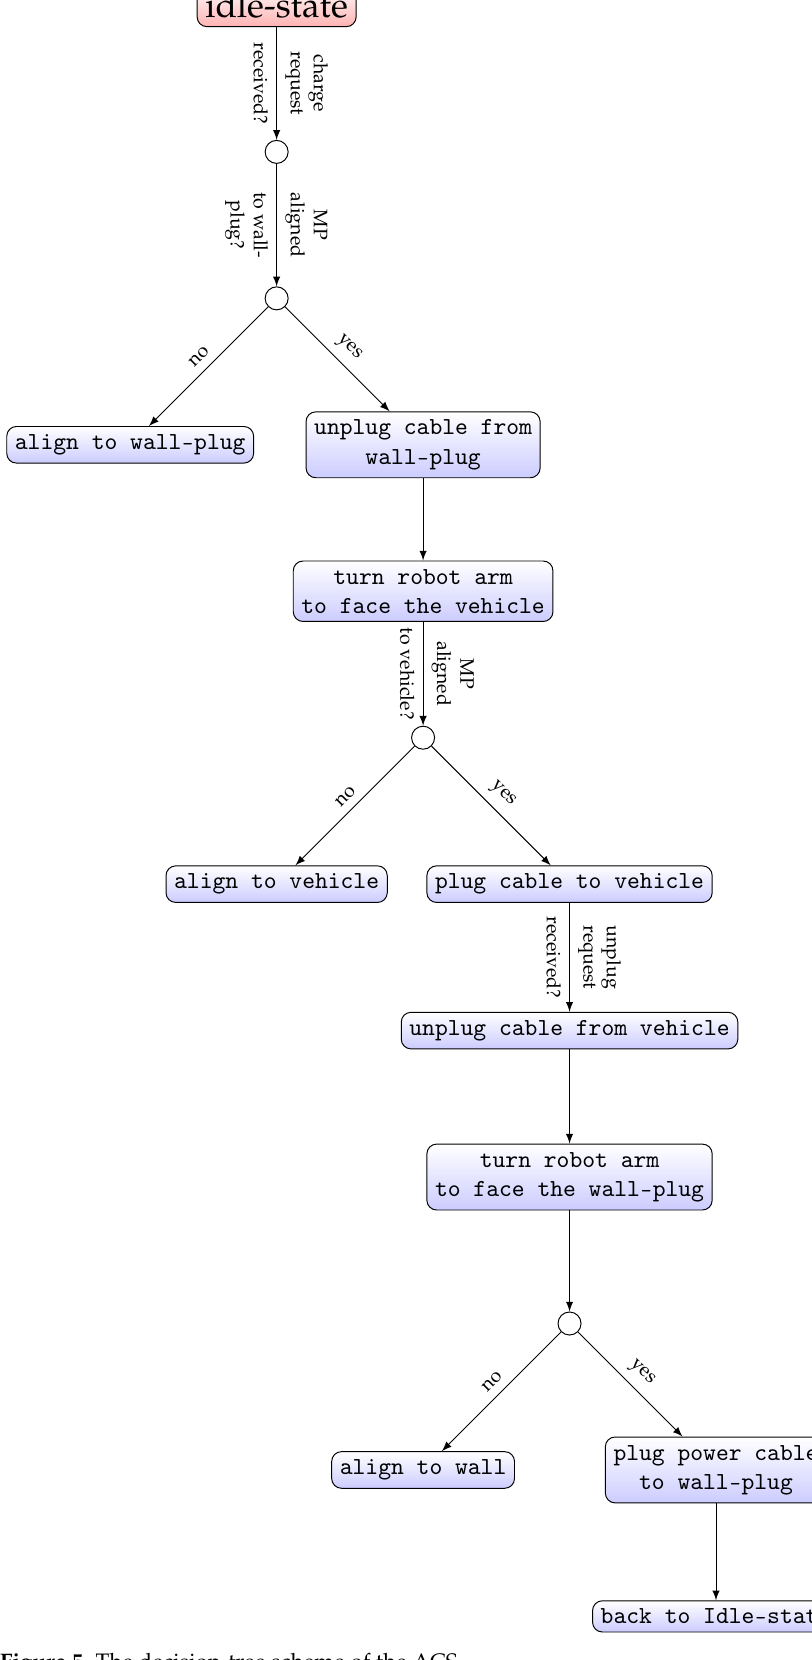
Figure 5. The decision-tree scheme of the